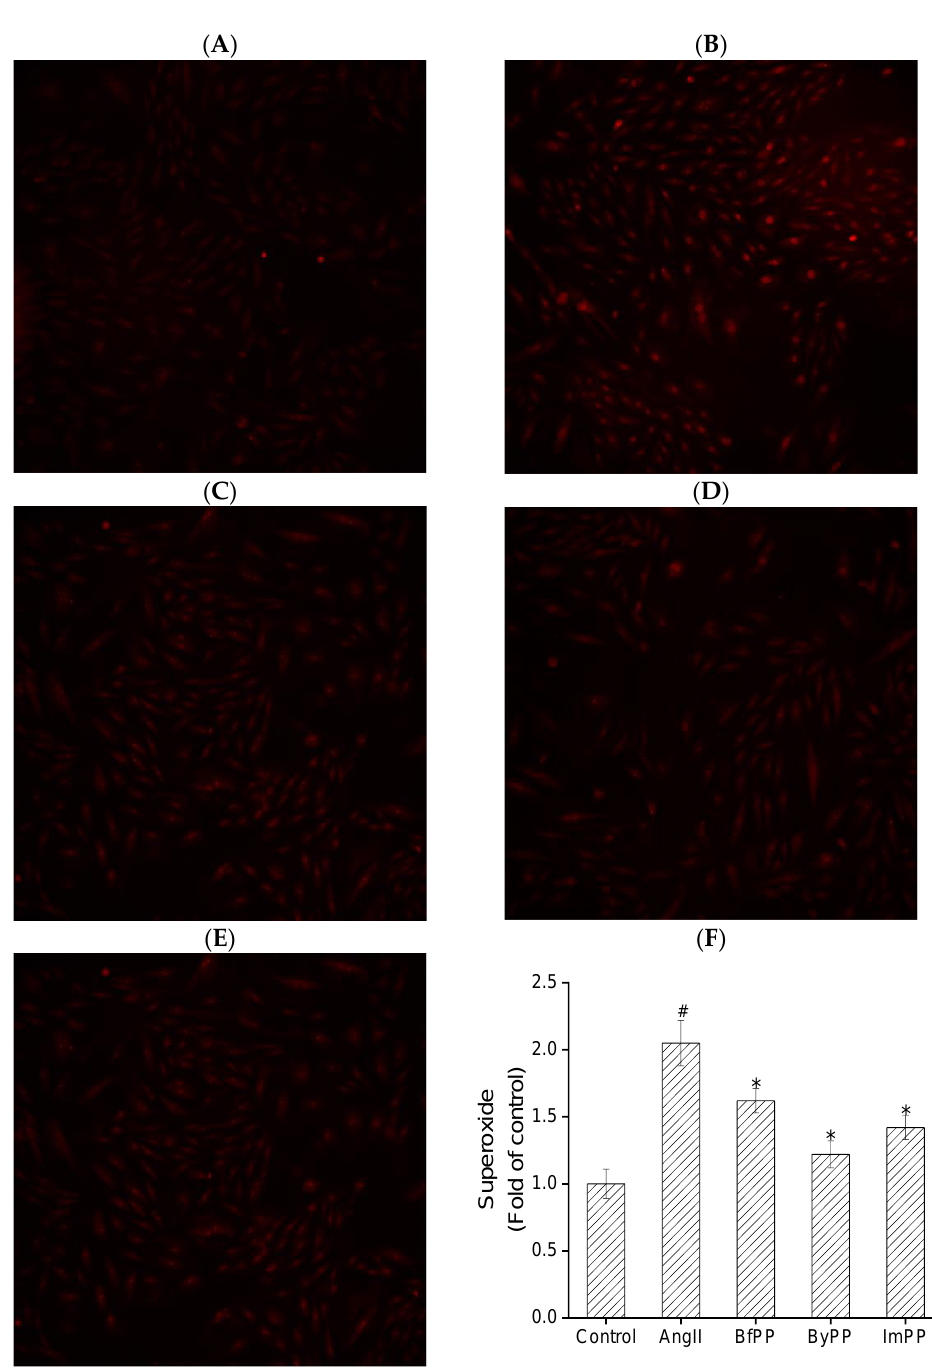
Figure 5. Effect of beef and PBMA hydrolysates prepared by gastrointestinal digestion on antioxidant capacity in A7r5 cells. ( A ) Control, ( B ) AngII, ( C ) BfPP, ( D ) ByPP and ( E ) ImPP, ( F ) oxidative stress in A7r5. The data are represented as means ± SD; # represents p < 0.05 vs. control group. * represents p < 0.05 vs. Ang II group.